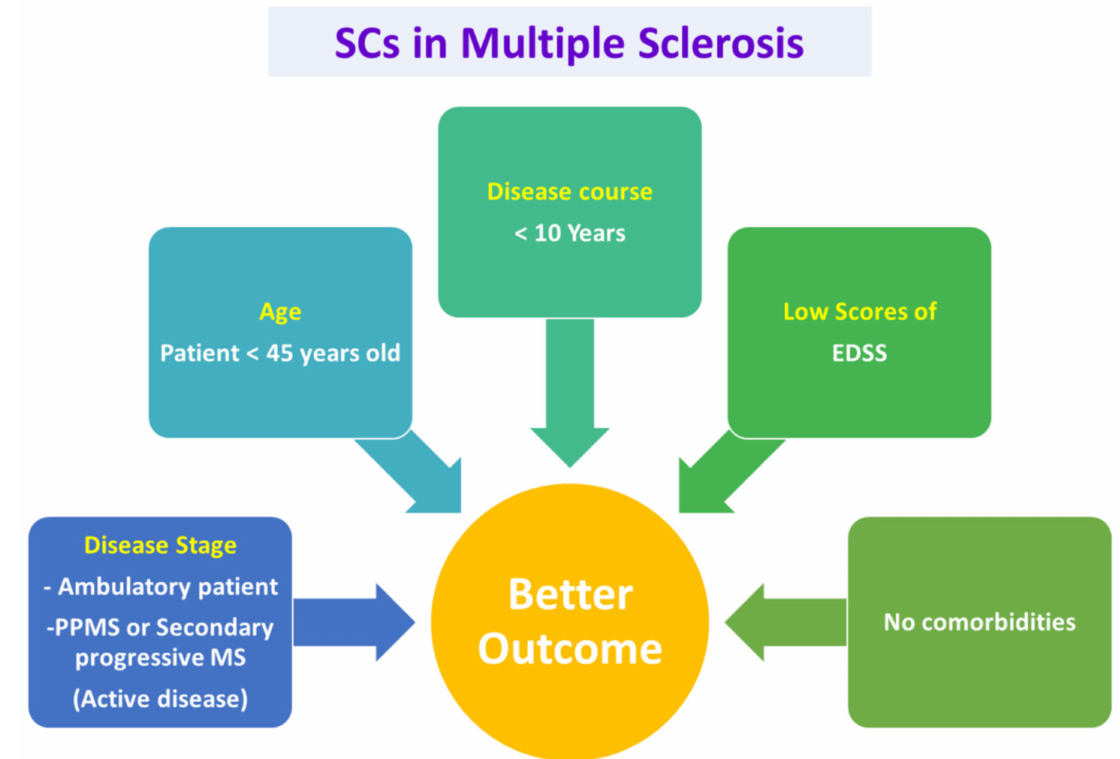
Figure 3. Selection criteria for patients of MS to be treated with aHSCs for a better outcome. Based on the EBMT and previous reports, Patients with early active disease stages, younger than 45 years old, with disease course lesser than 10 years and low scores of EDSS and no comorbidities are found to have better outcome on transplantation of autologous stem cells. EDSS: Kurtzke’s Expanded Disability Status Scale, EBMT: European Group for Blood and Marrow Transplantation.